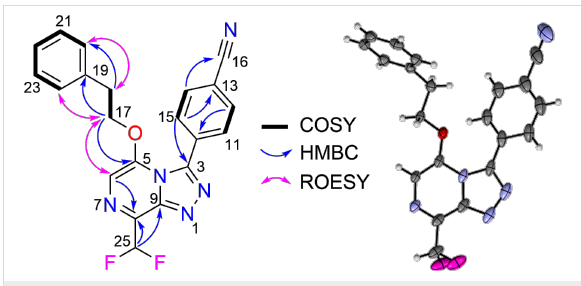
Figure 1: Key HMBC, COSY and ROESY correlations, and ORTEP drawing of 18 .